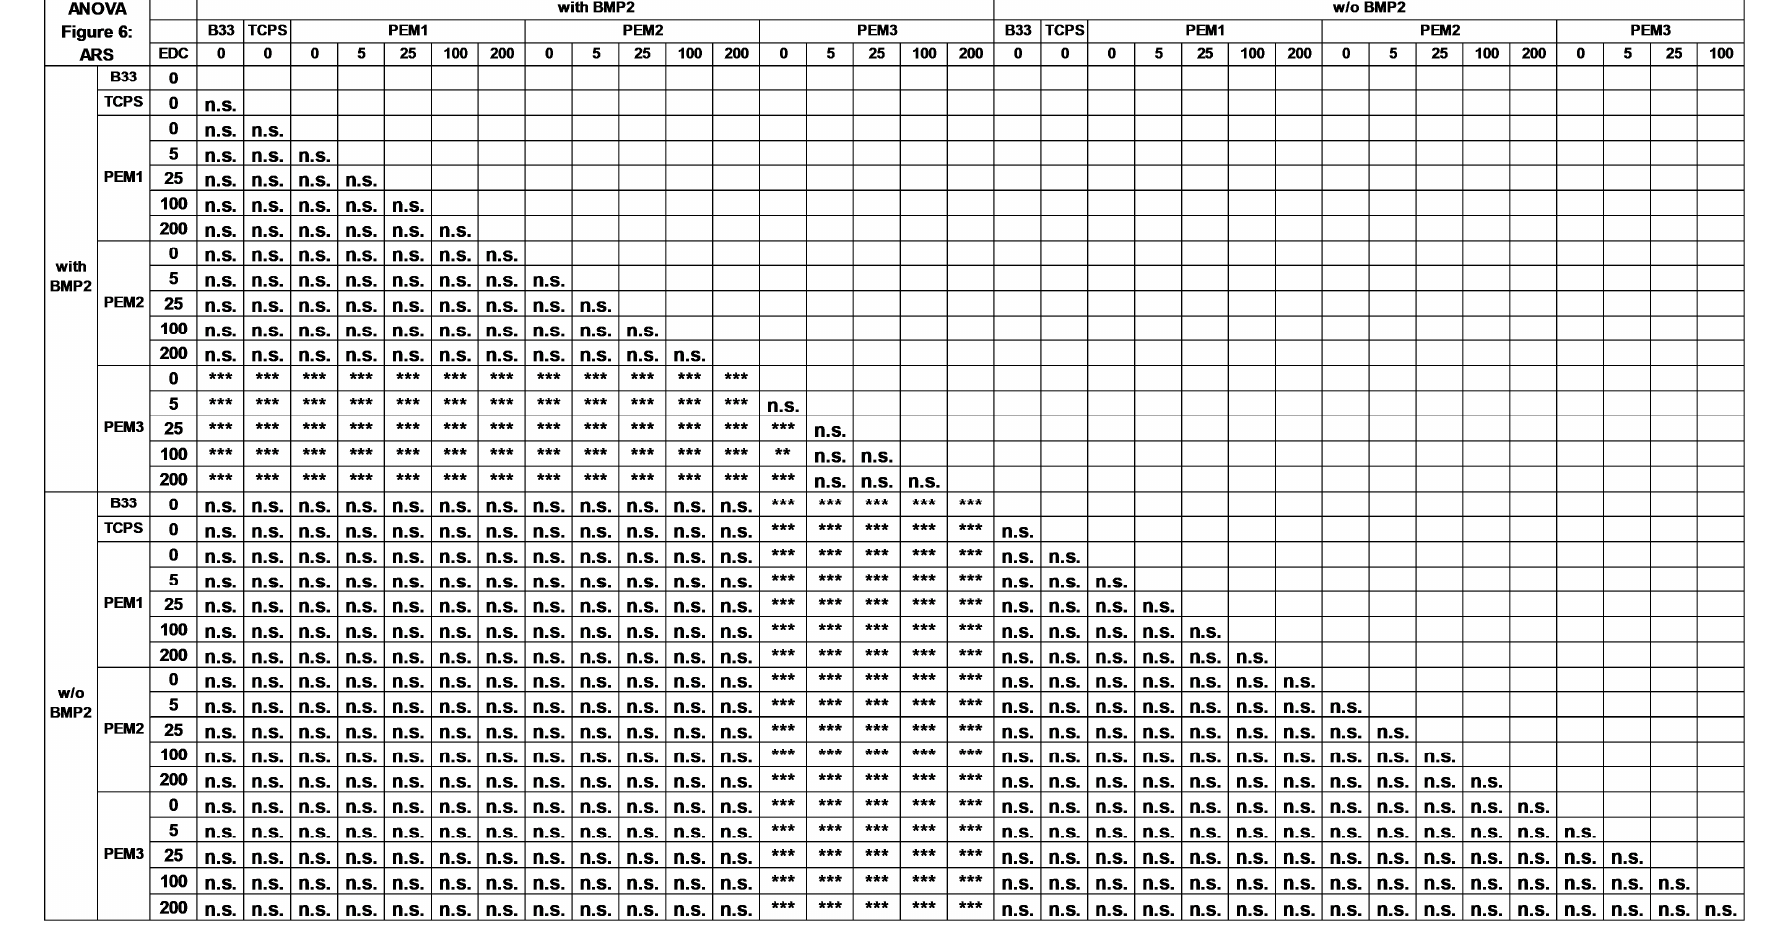
Figure A6. Results of one-way ANOVA for data related to Figure 6; n.s.: not significant; *: p < 0.1; **: p < 0.05; ***: p < 0.001.